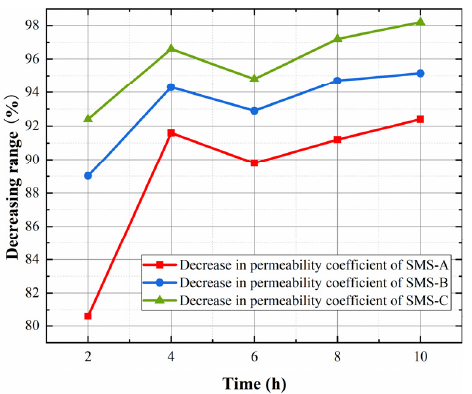
Figure 14. Decrease in permeability coefficients of soils after different hydrophobic treatments.